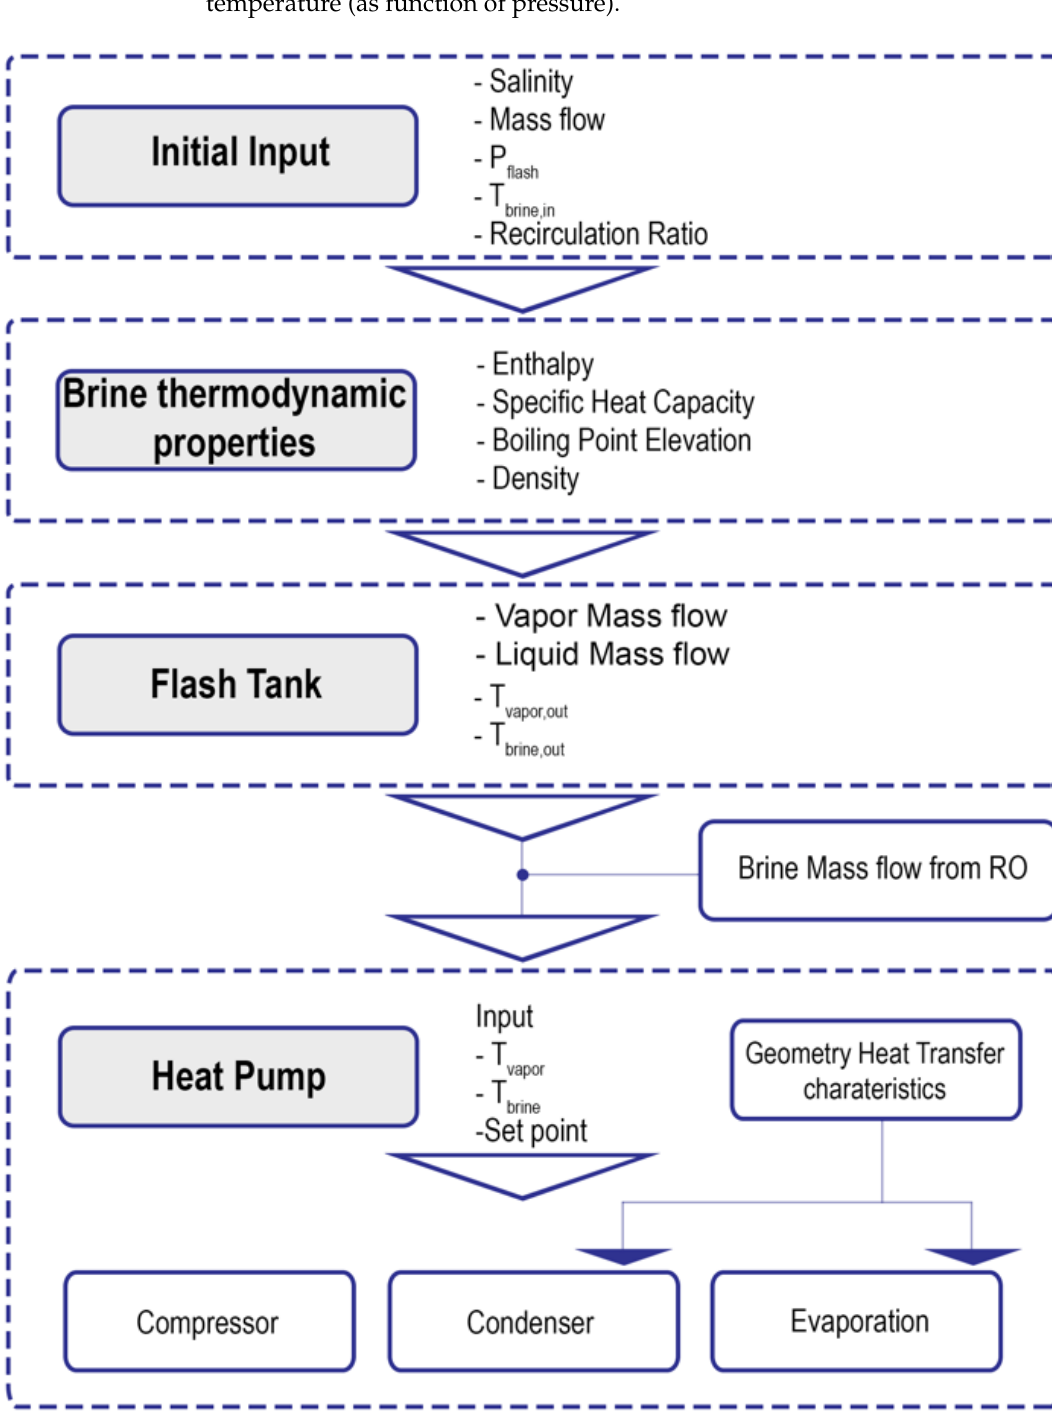
Figure 3. Flowchart of the numerical process.